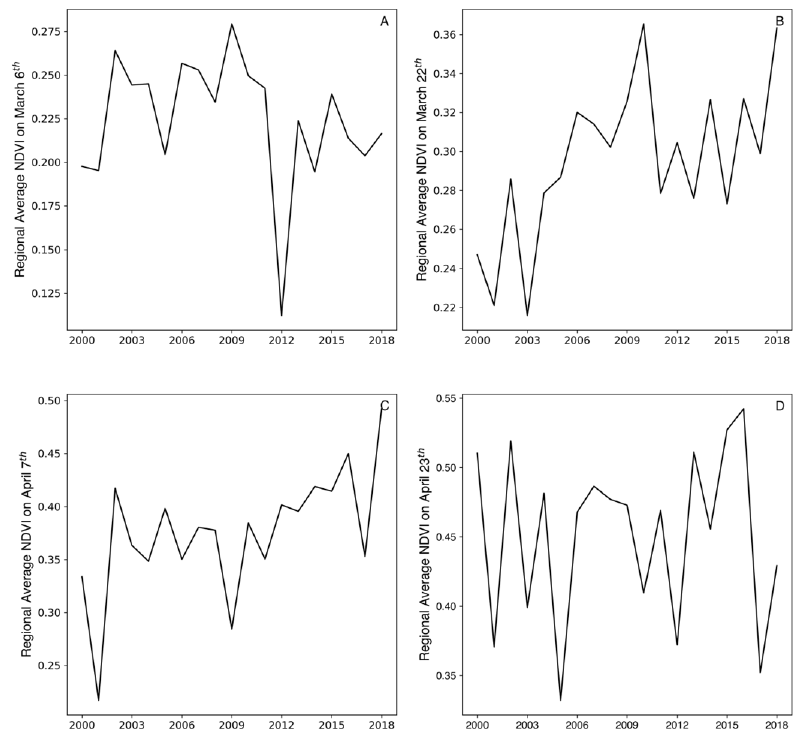
Figure 14. Regional-averaged 16-day MODIS NDVI on selected dates in the spring.